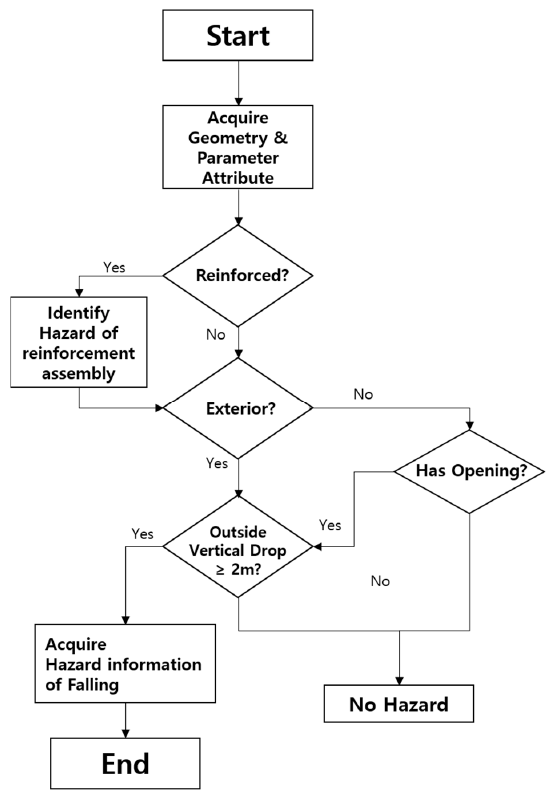
Figure 2. Fall hazard recognition algorithm.